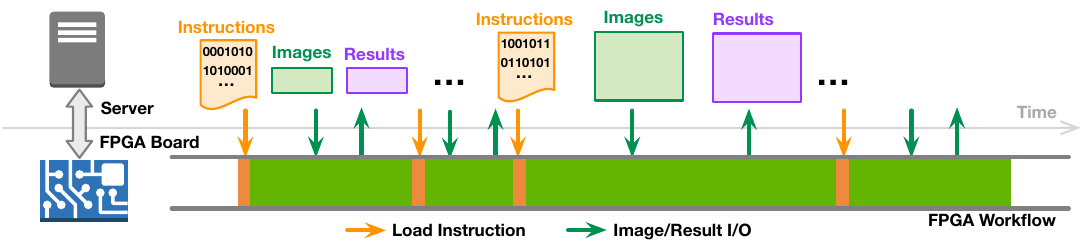
Figure 8. D-SWIM workflow with dynamic programming for arbitrary sized image